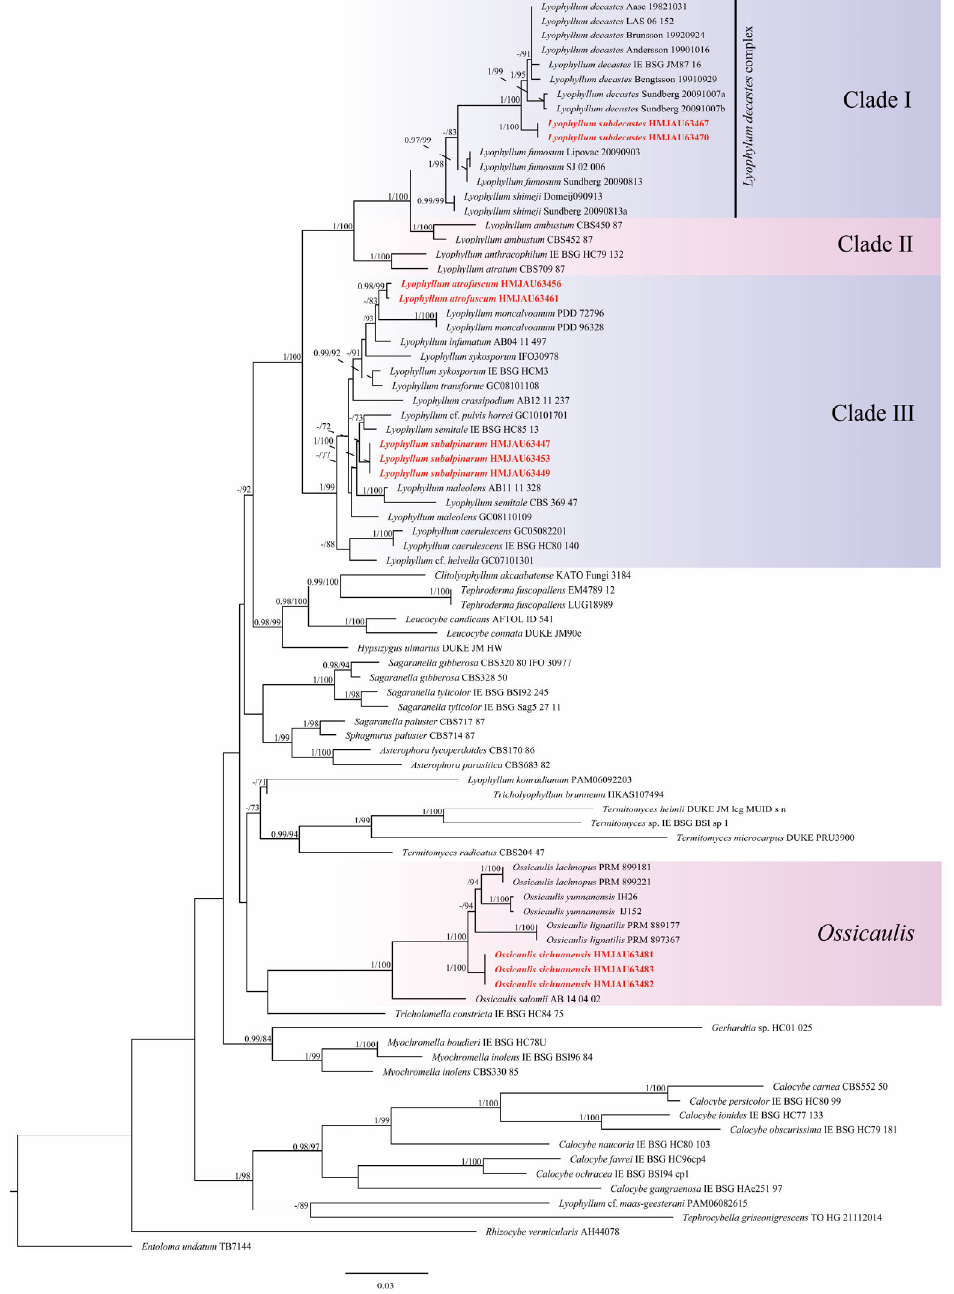
Figure 1. Phylogenetic tree performed by ML analysis based on ITS + nLSU sequences. Branches are labeled with Bayesian posterior probabilities ≥ 0.95 and ML bootstrap values ≥ 70%. The new species are indicated in red.